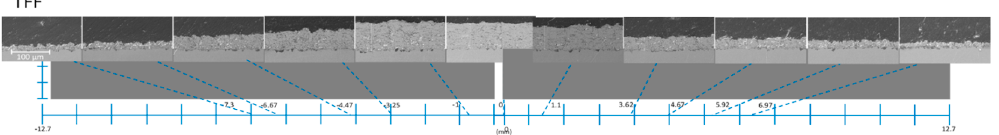
Figure 17. Cross-section images showing the columns in cylindrical sample with fine grit blasting (TFF).